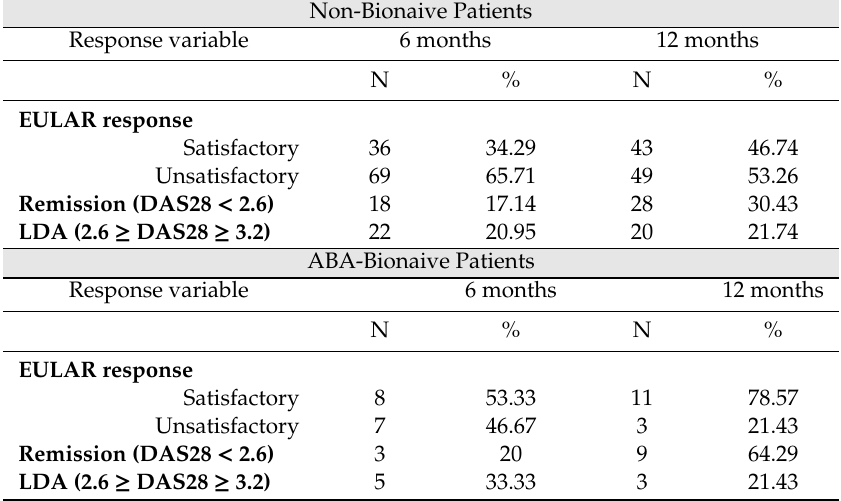
Table 2. Clinical E ff ectiveness of Abatacept in non-bionaive and ABA-bionaive